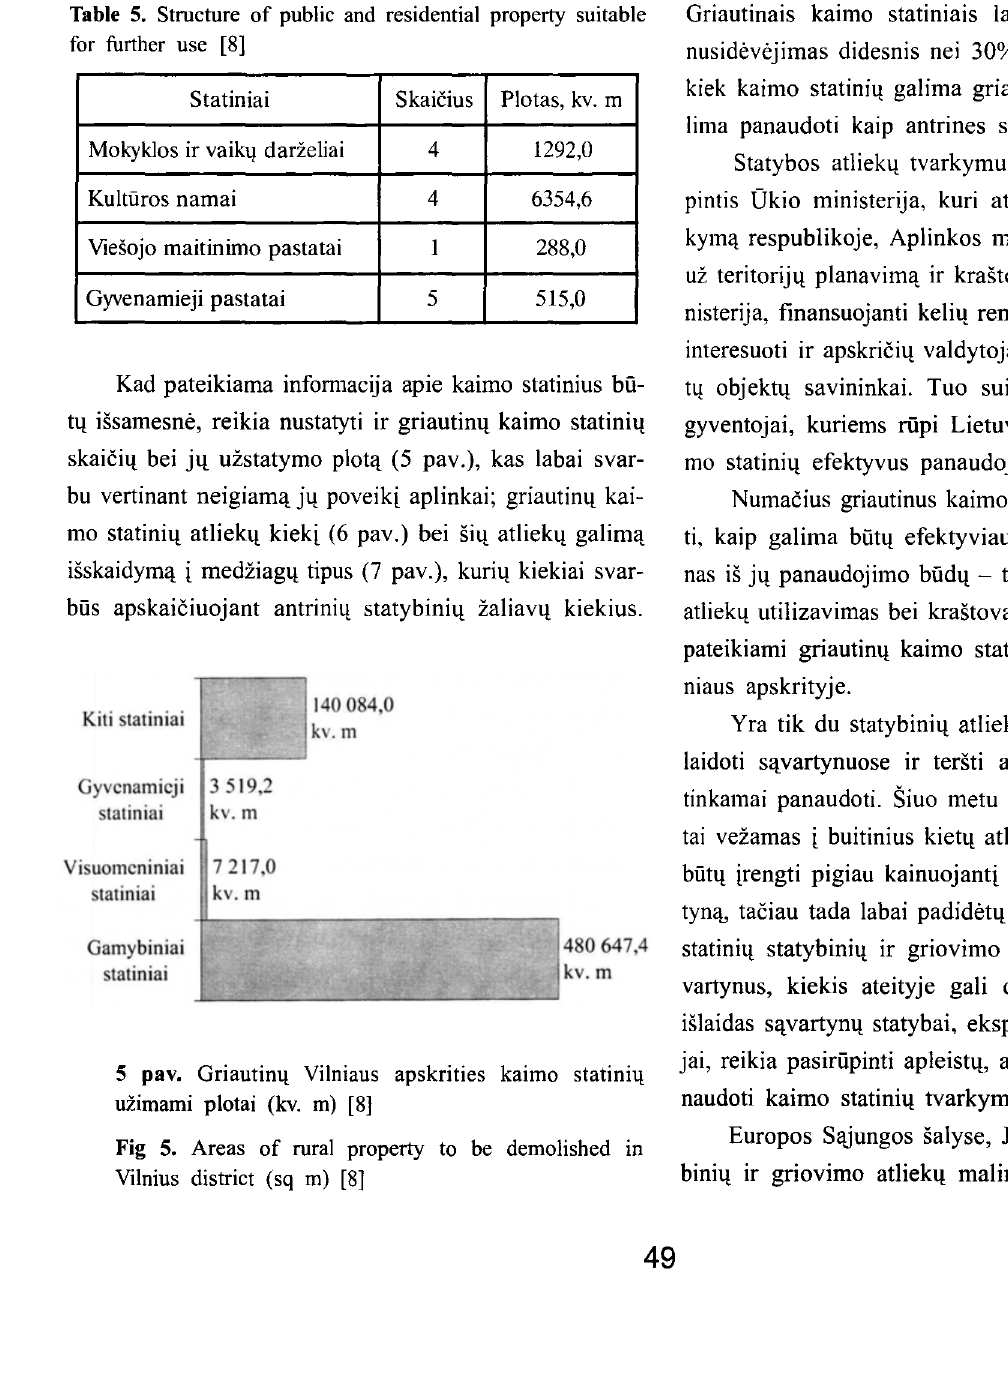
Table 5. Structure of public and residential property suitable for further use [8]